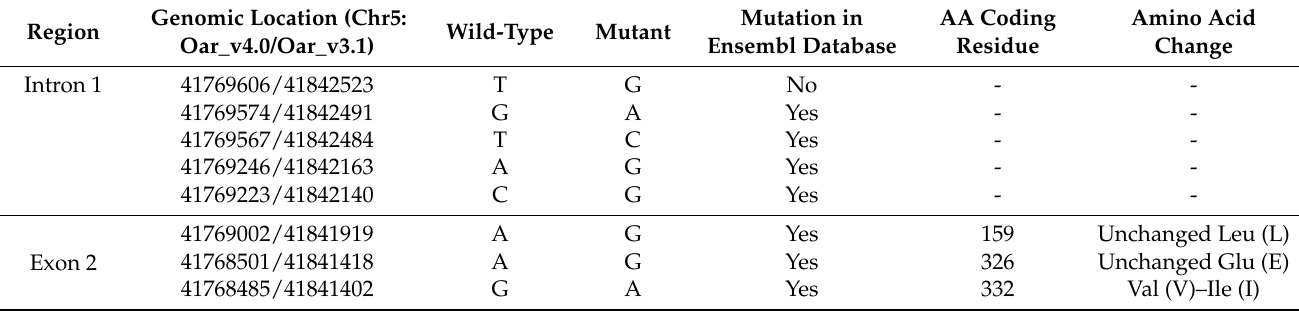
Table 2. The information of eight mutation loci in the GDF9 gene of Luzhong sheep.